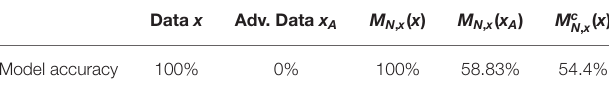
TABLE 2 | M N , x ( x ) and M N , x ( x A ) denote original images/adversarial images filtered by masks trained for original images from the vanilla